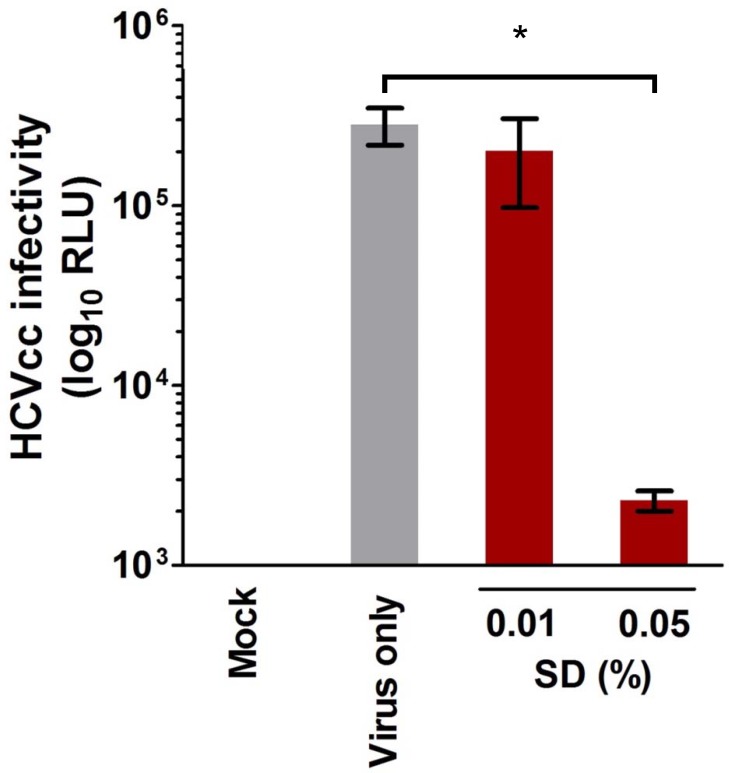
SD directly inactivates HCV particles.To test the specificity of SD in inactivating HCV particles, cell-free virus was co-incubated with low dose SD (0.01%, 0.05%) for 3 h and then diluted 50× to sub-cytotoxic concentrations of the treatment before infecting Huh-7.5 cells (MOI = 0.01). Viral infectivity was measured by luciferase reporter activity (RLU). Data shown are collected from three independent experiments with means ± SEM (*: P < 0.05).